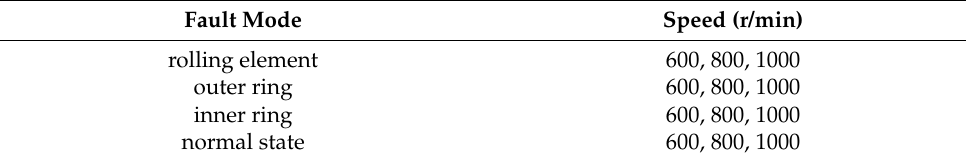
Table 5. Detailed description of the bearing